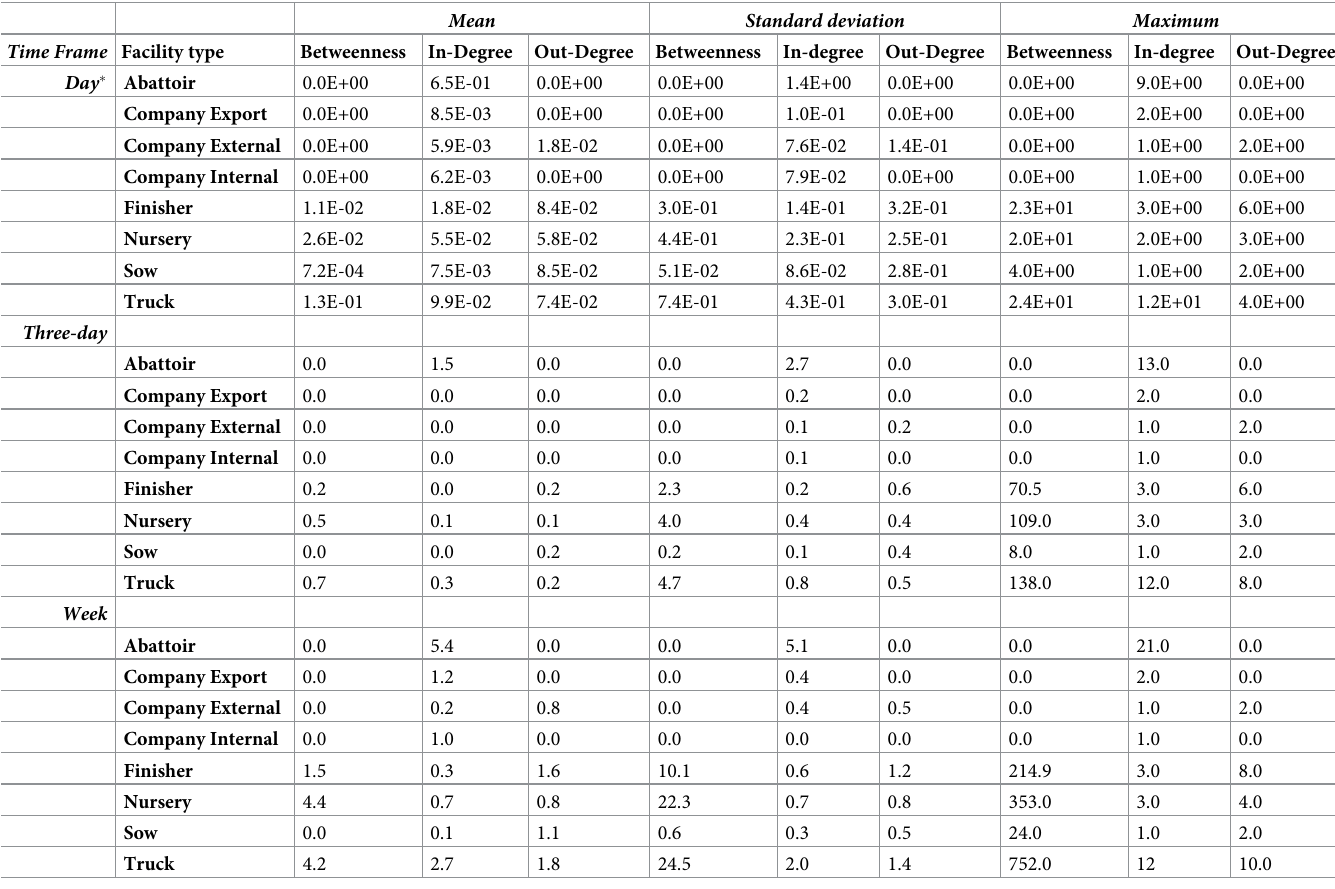
Table 1. Descriptive statistics of the node-level centrality measures calculated from daily, 3-day and weekly networks during 2015 in an Ontario swine production system, stratified by the type of facility. Mean Standard deviation